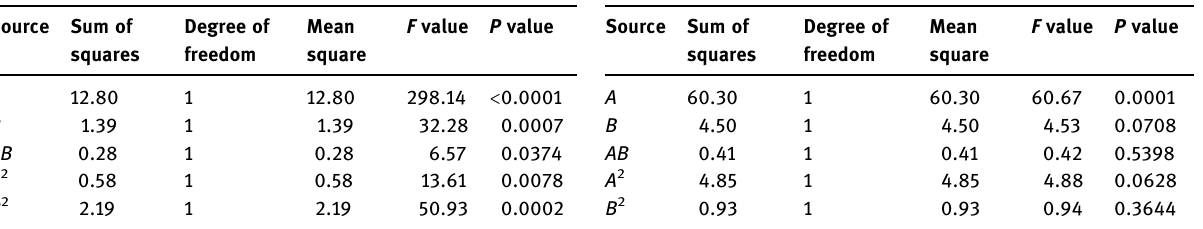
Table 5: Variance analysis of fi xed carbon content